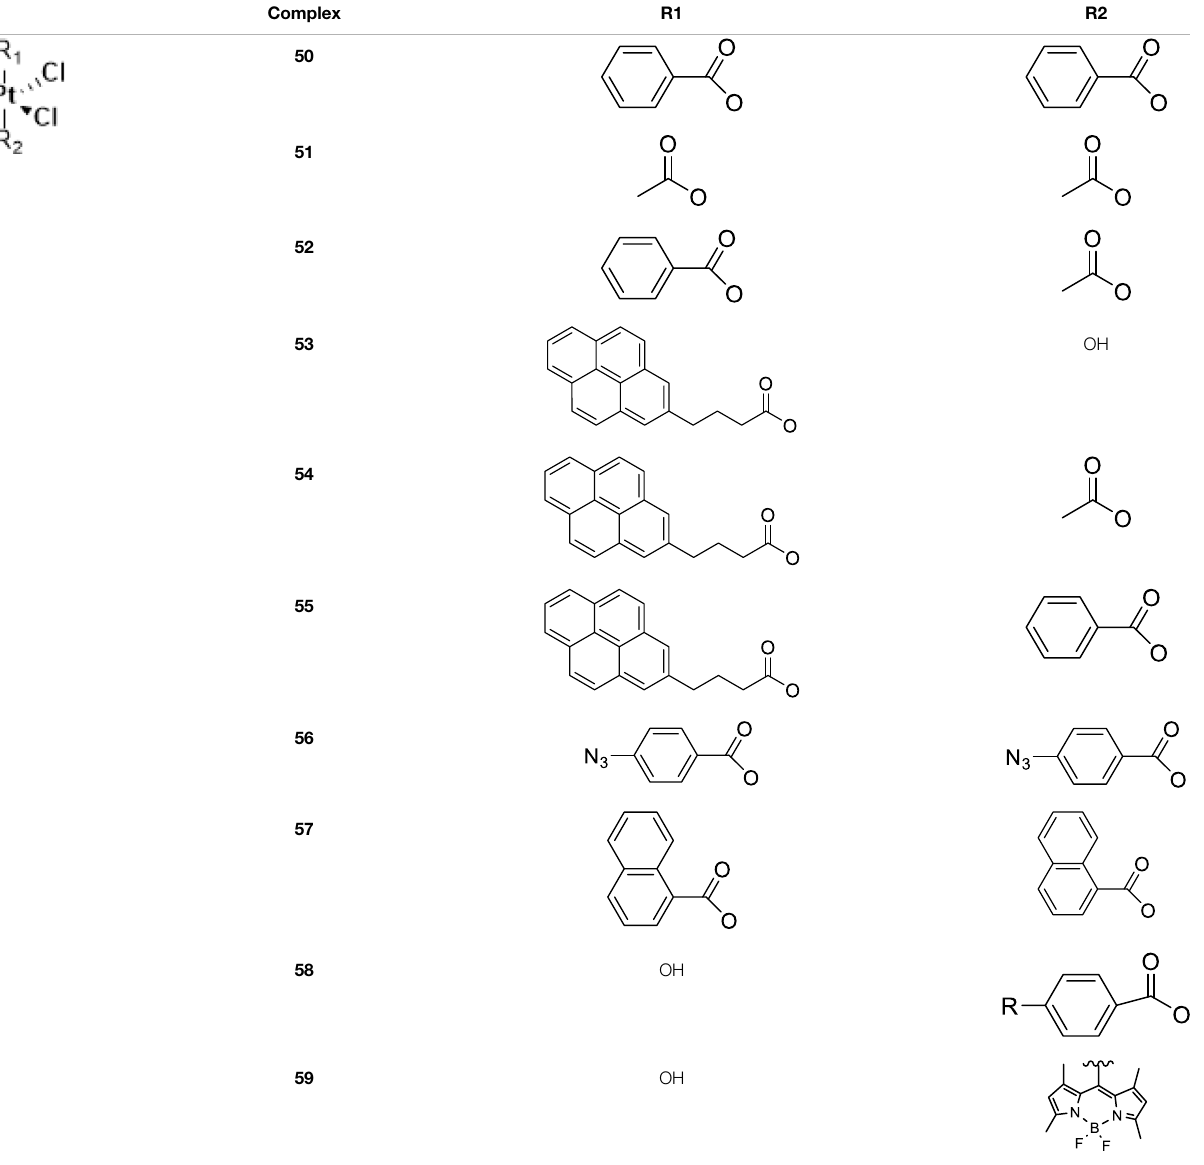
TABLE 6 | Chemical structures of complexes 47 – 56 .